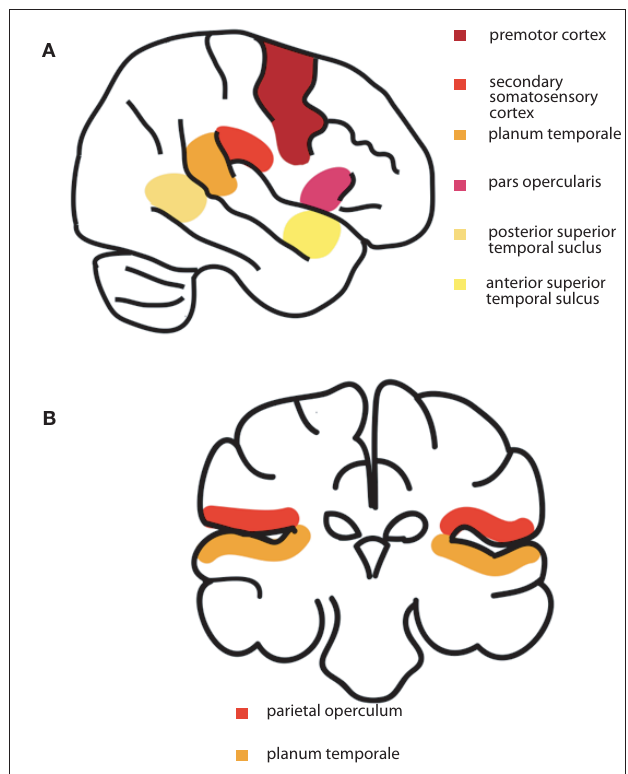
FIguRe 2 | (A) A schematic diagram of the cortical systems involved in spoken language production: premotor cortex, secondary somatosensory cortex, planum temporale, angular gyrus, pars opercularis, and superior temporal gyrus. (B) Higher-order auditory and somatosensory regions that are modulated in bilingual speech production; parietal operculum on the upper bank of the Sylvian fissure, and planum temporale on the lower